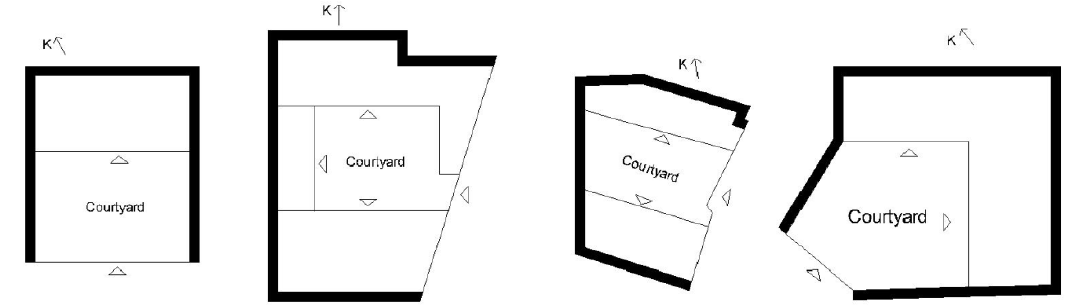
Figure 8. Types of Traditional Gaziantep Houses (Adopted from, Tas¸do˘gan, A. D. 2008)